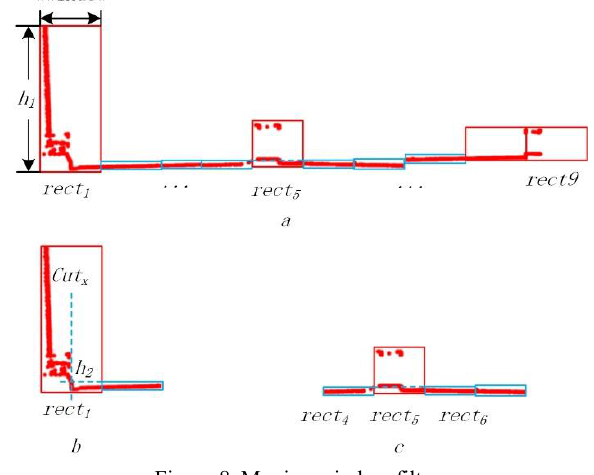
Figure 8. Moving window filter